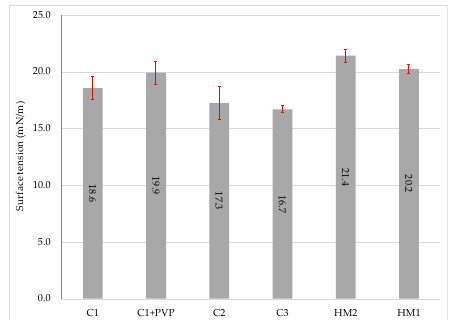
Figure 5. Surface tension of various suspensions.